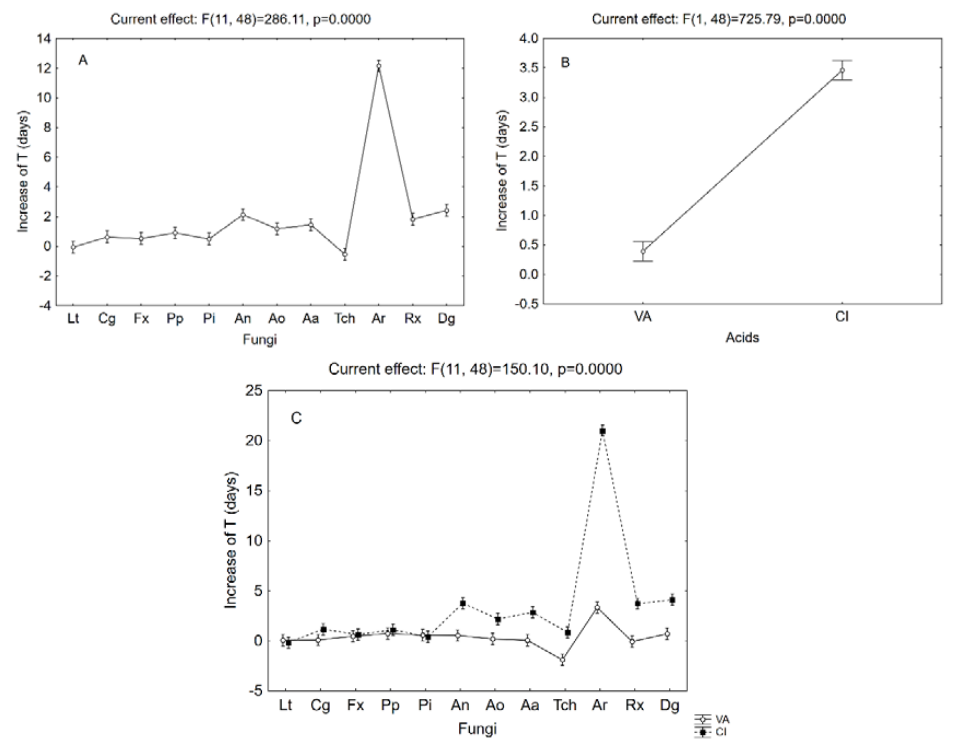
Figure 1. Effective hypothesis decomposition of the multi-factorial analysis of variance (MANOVA) on Δτ (increase in time to attain half maximum diameter) (days). Effects of fungi species (for abbreviations, see Table 1) on ( A ) acids, ( B ) interaction fungus* acid, ( C ) (VA, vanillic; CI, cinnamic acid). Vertical bars indicate 95% confidence intervals. The F-test and relative degrees of freedom are given at the top of each panel.